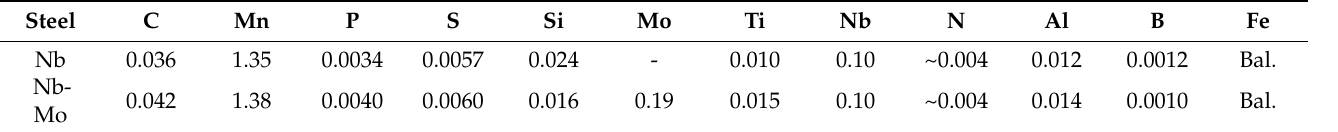
Figure 1. Schematic diagram of the TMCP process. Table 1. Chemical compositions of the investigated steels (wt.%).